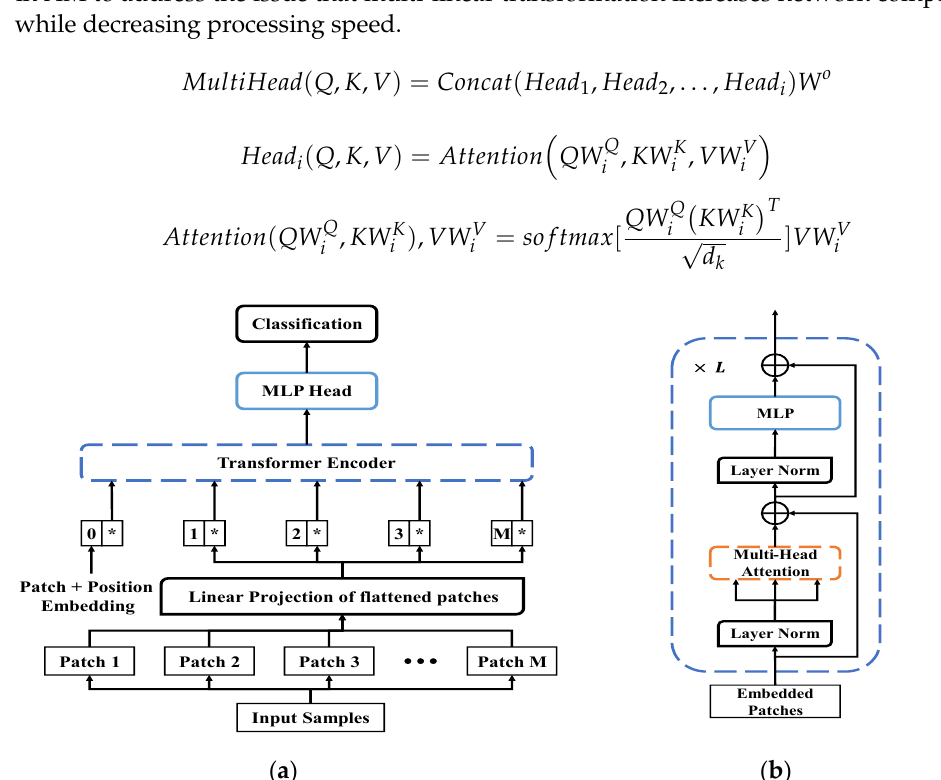
Figure 1. Vision transformer: ( a ) ViT’s structure; ( b ) Transformer encoder.